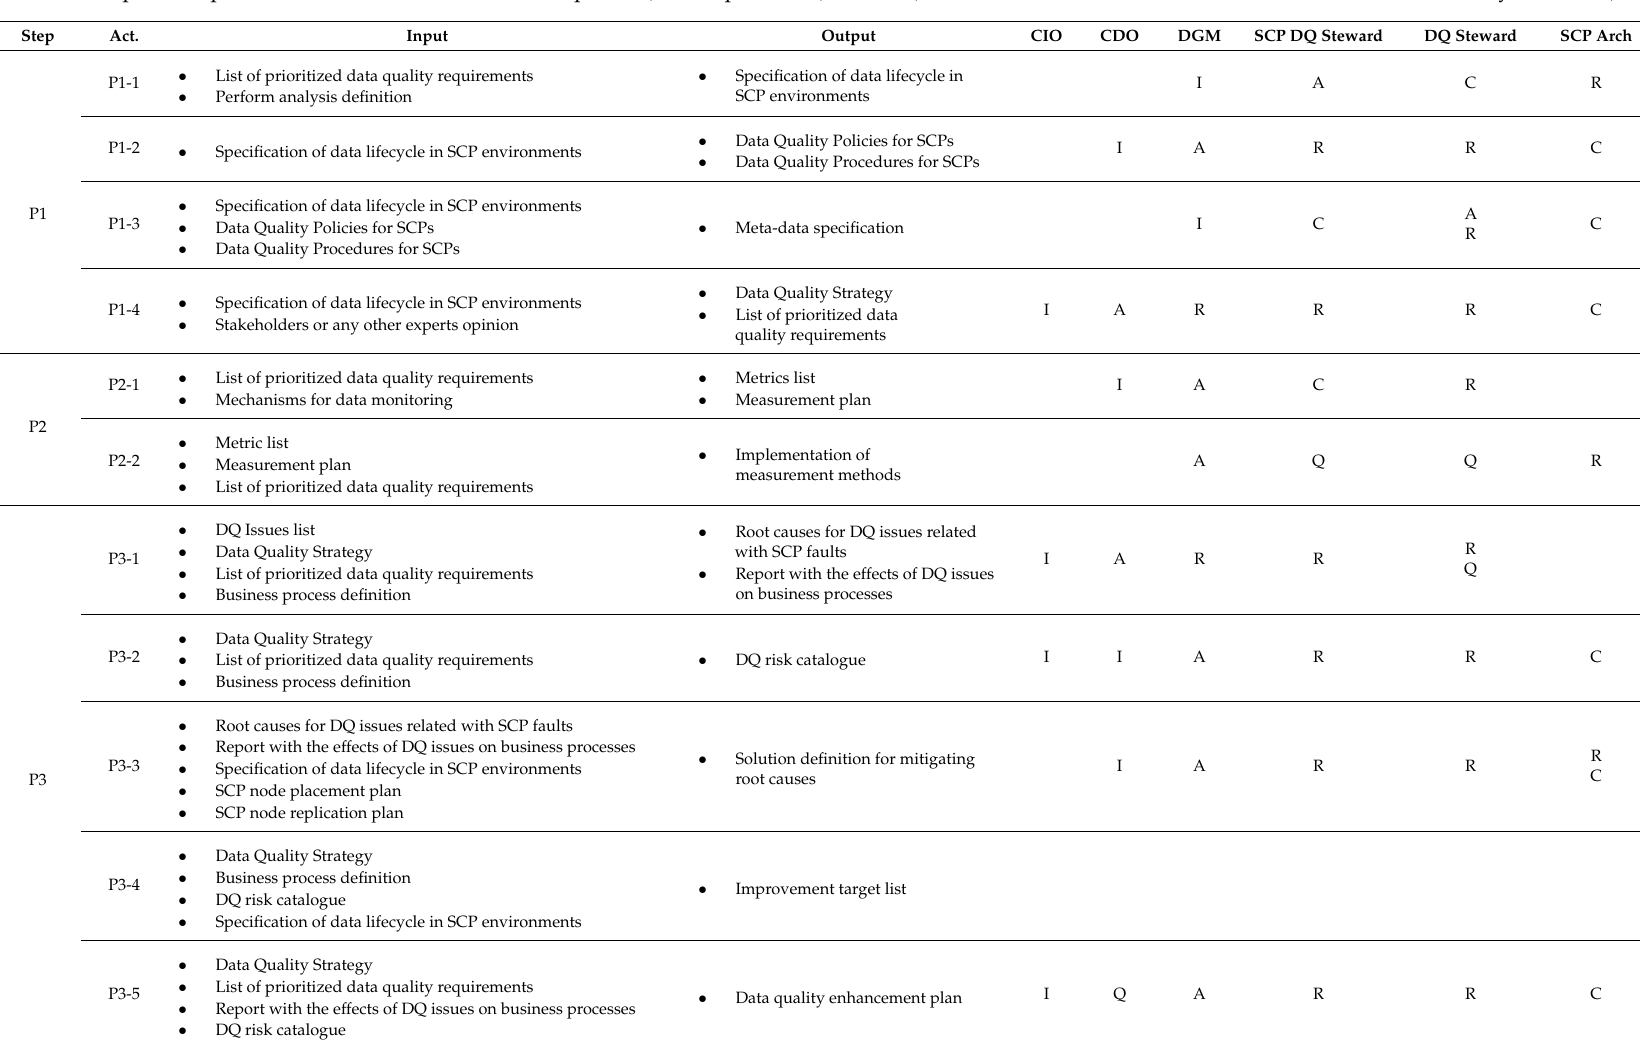
Table 5. Inputs, outputs and RACIQ matrix for the Plan phase. (R—Responsible (works on); A—Accountable, C—Consulted; I—Informed; Q—Quality Reviewer). Step